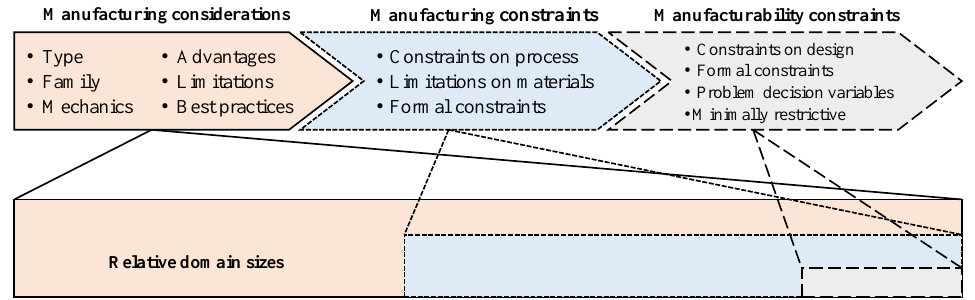
Figure 4. Basic mapping and domain sizes for general manufacturing